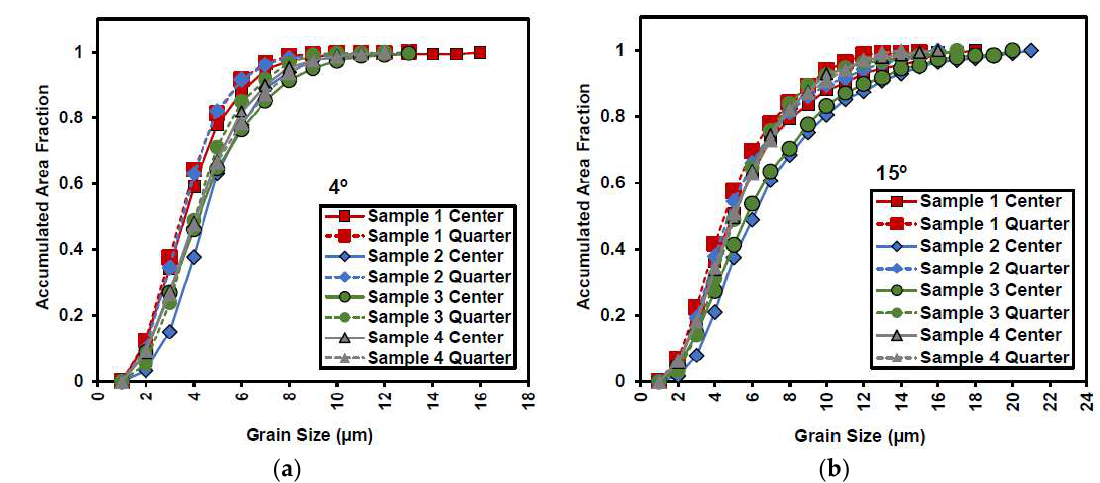
Figure 8. Comparison between the grain size distribution obtained in the different samples and both positions of thickness (quarter and center): ( a ) low-angle- and ( b ) high-angle-misorientation criteria.